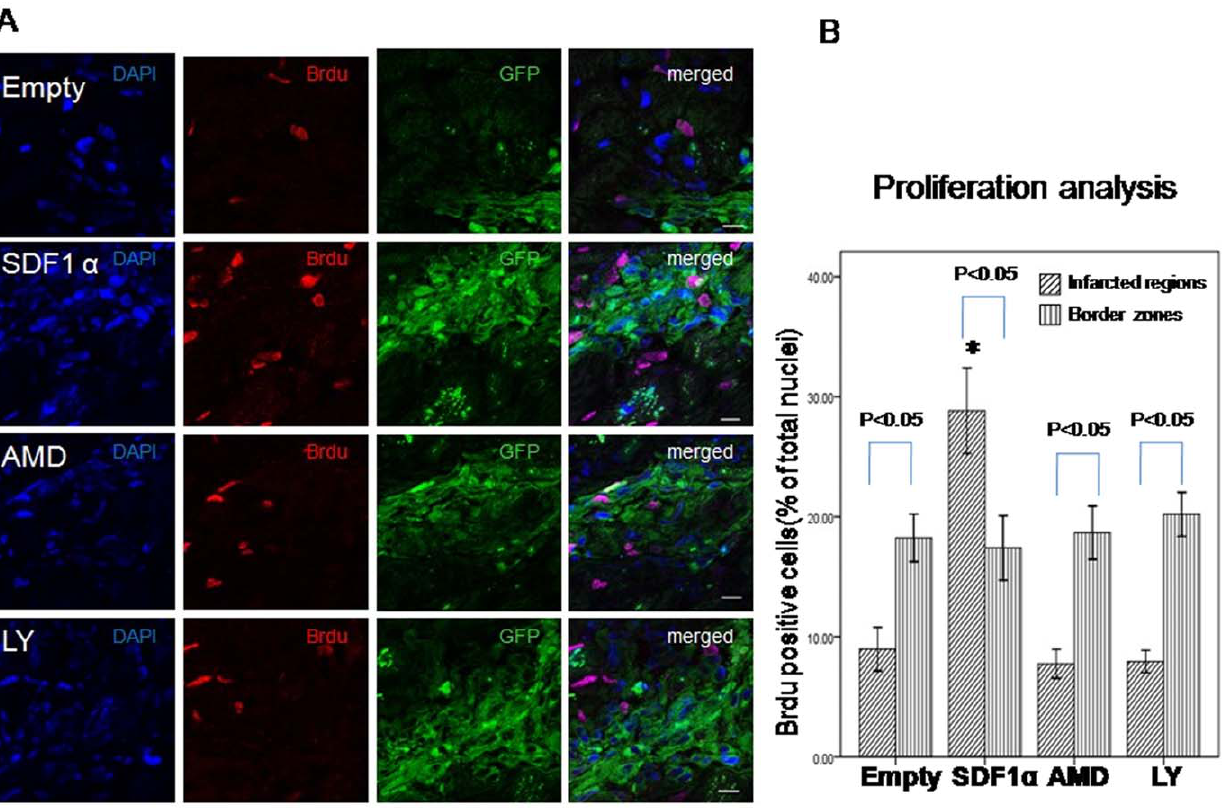
Figure 4. Proliferation of transplanted CSCs. A . proliferation of transplanted CSCs was determined by Brdu and DAPI double staining (red and blue) 3 weeks after myocardial infarction. Scale bar=10 m m. B . Quantitative analysis of the ratio of Brdu/DAPI double positive cells. Data were shown as mean 6 SD. * P , 0.01 vs. Empty, AMD and LY group in infarcted zone. n=6.